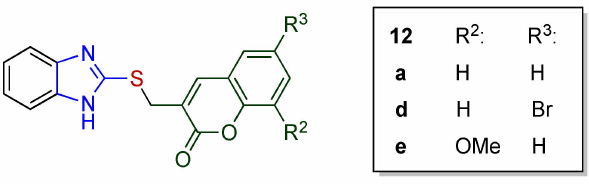
Figure 2. Structure of benzimidazole–coumarin